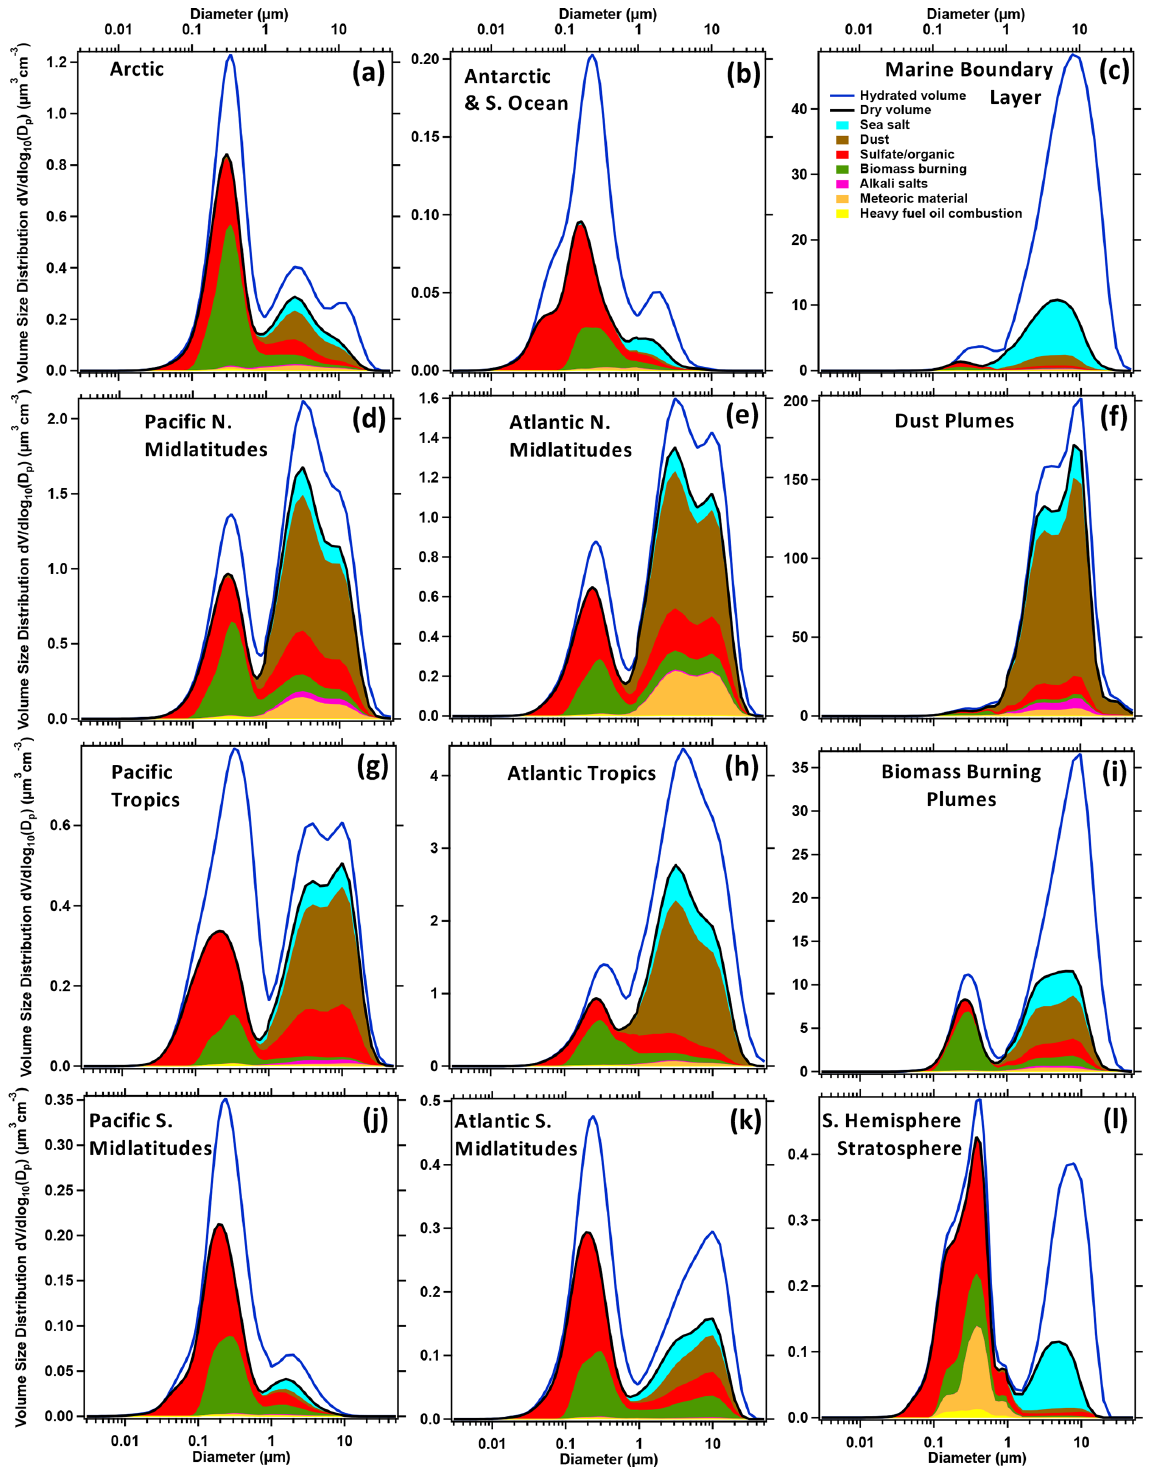
Figure 11. Volume of particles of different aerosol types as a function of diameter, averaged over all data in different regions and air mass types across all of the ATom deployments. Note that scales on the y axes vary. Descriptions of the regions are given in Fig. 7 and Table S1. Regional data (left two columns) are from the FT only and exclude data from BB and dust plumes as well as stratospheric intrusions. Size distributions from the MBL, stratosphere, and BB and dust plumes (right column) are not separated by ocean basin or latitude range. One pass of a binomial smoothing filter (Marchand and Marmet, 1983) has been applied to the data; PALMS particle types shown below 0.14µm are extrapolated for